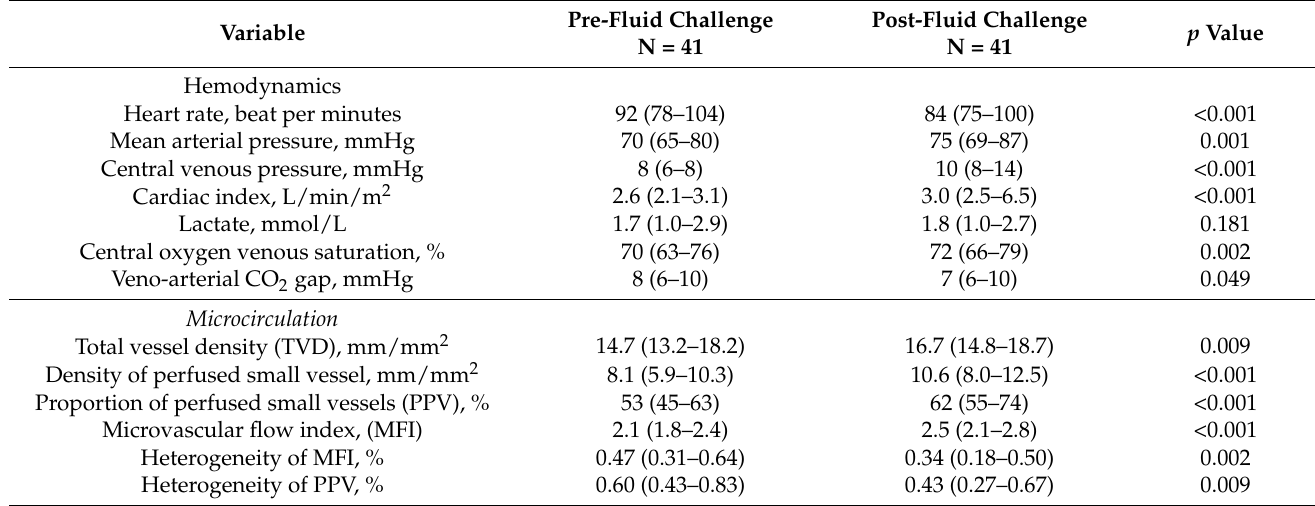
Table 2. Hemodynamic and microcirculatory parameters before and after the fluid challenge. Data were expressed as median